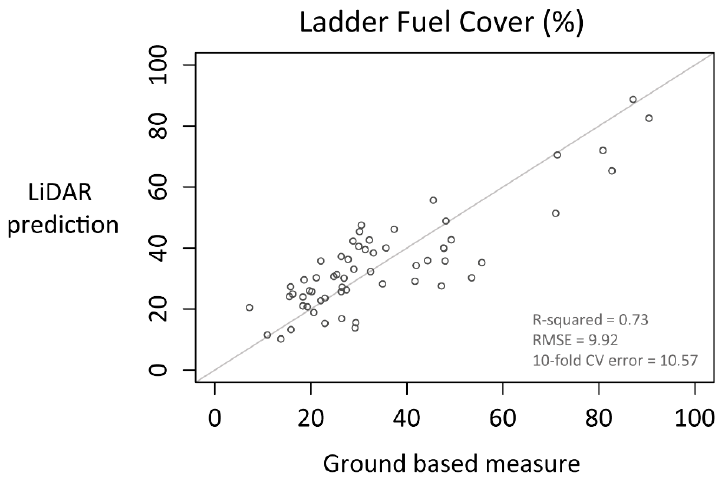
Figure 9. Ladder fuel cover derived from the LiDAR point cloud is compared to ground-based measurements. This model is significant at the p < 0.05 level, with an R-squared value of 0.73, root mean squared error of roughly 10%, and 10-fold cross-validation error of roughly 11%. The ground-based measurements range between 7% and 91% ladder fuel cover.